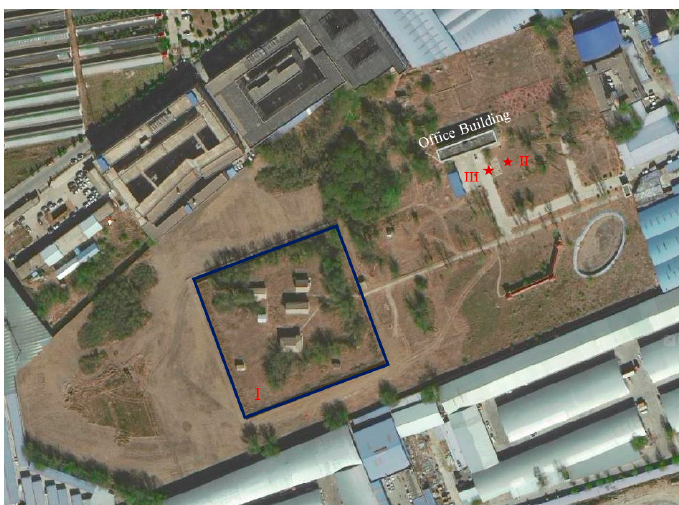
Figure 1. Satellite view of the fluid observation well considered herein and the local facility layout. I, geomagnetic observation area; II (right red star), observation wells; III (left red star), WYY-1 com- prehensive temperature, pressure, and rainfall meters. comprehensive temperature, pressure, and rainfall